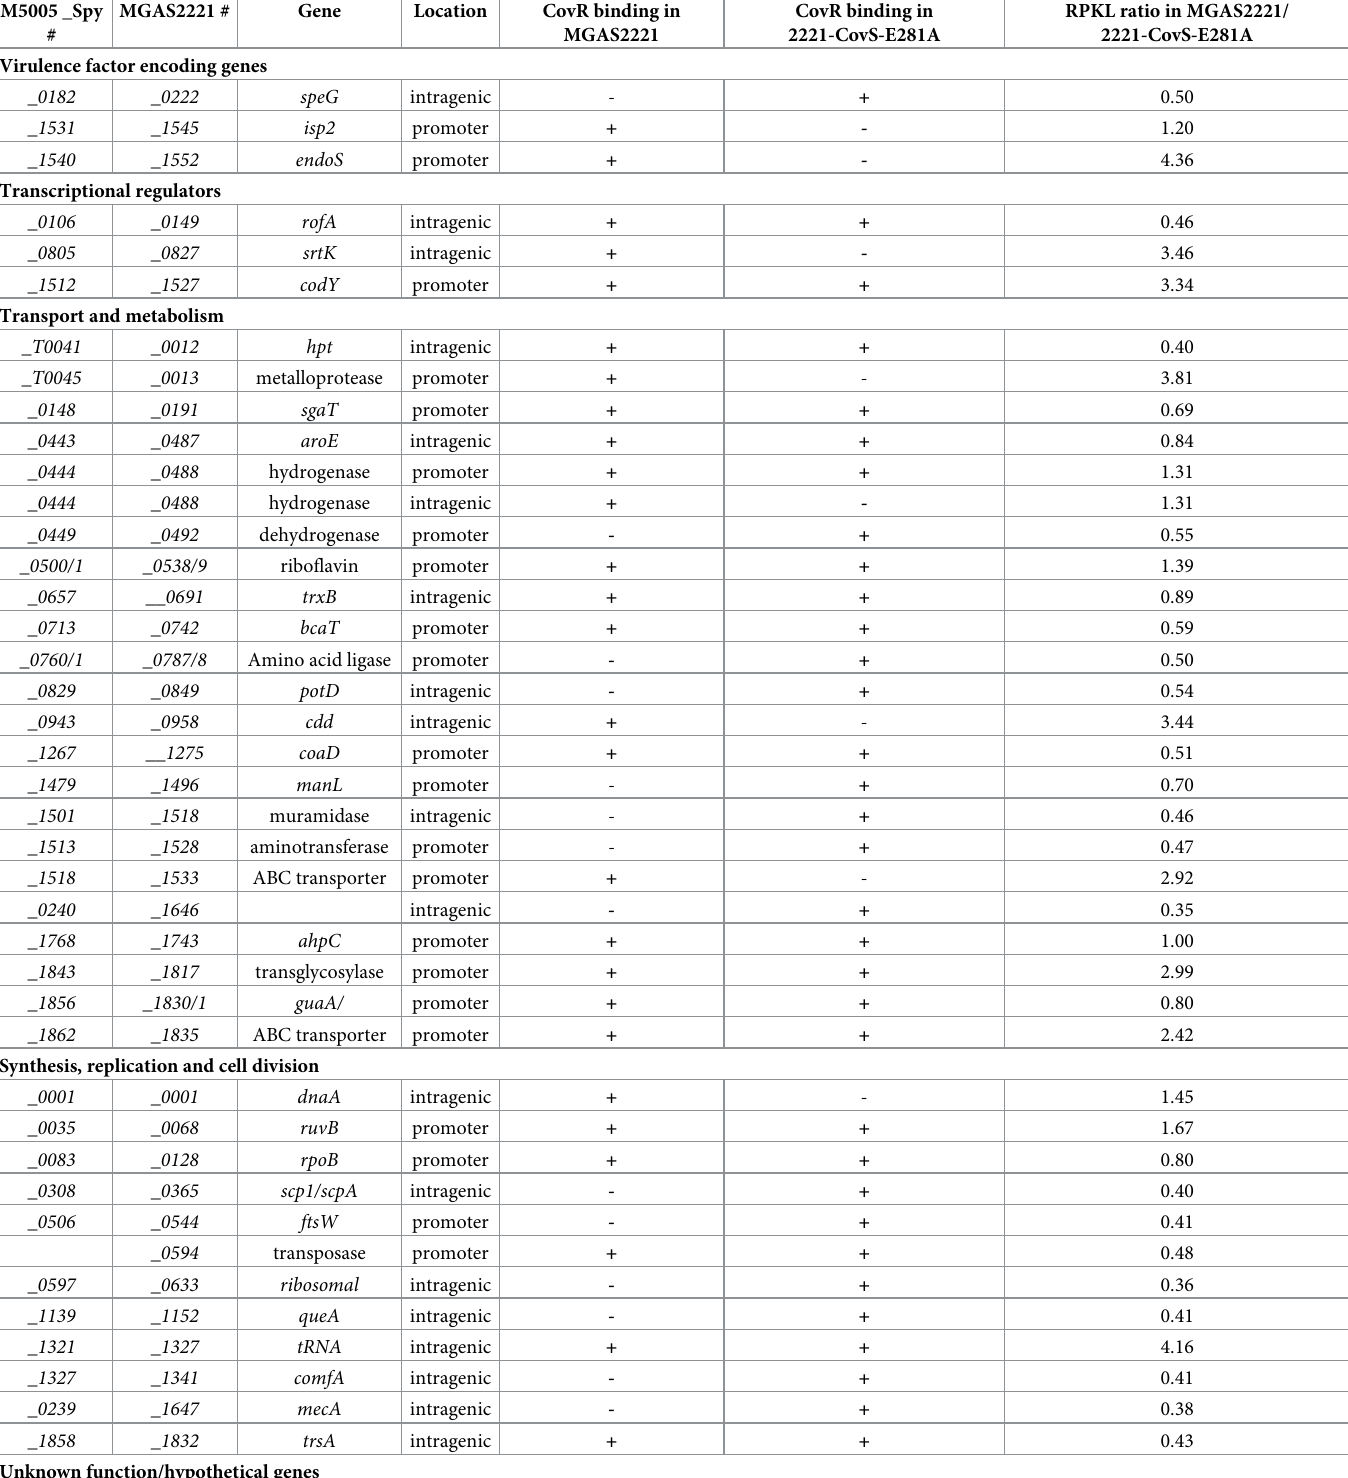
Table 3. Peaks at genes not regulated by